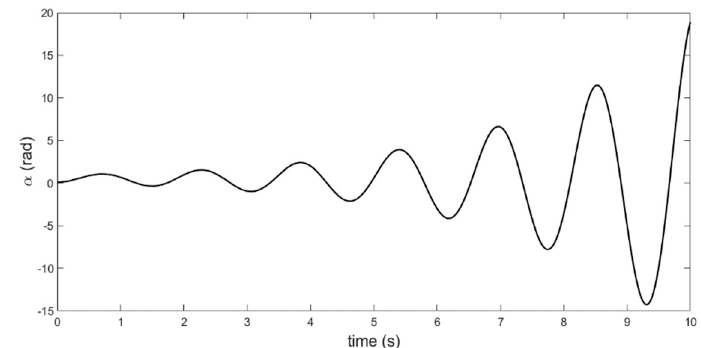
Figure 11. Time response of alpha in upper speed of flutter (35 m/s).